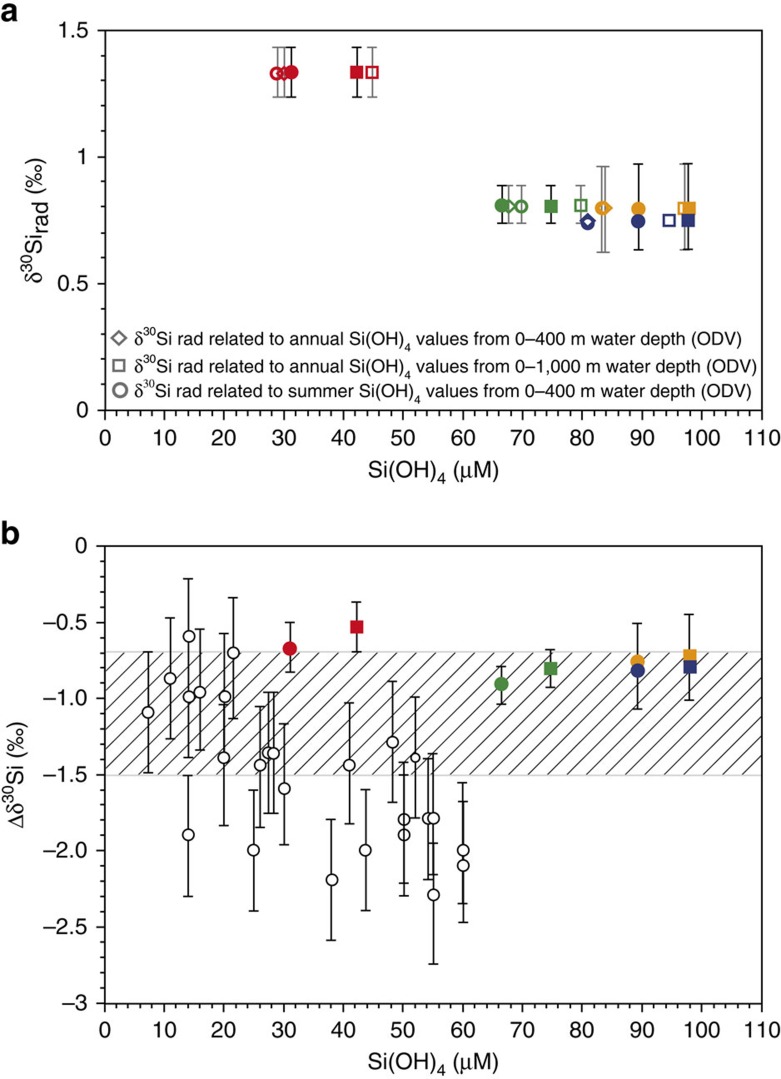
δ30Si data of radiolarians (δ30Sirad) and Δδ30Si offsets in surface sediments compared with Si(OH)4 concentrations and to Δδ30Si offsets of diatoms.(a) δ30Si data of radiolarians (δ30Sirad) in four surface sediments from the study area compared with Si(OH)4 concentrations in sea water. Colours refer to different surface sediments (red: PS63/026-2, green: PS63/035-2, blue: PS63/042-2, orange: PS63/043-2) (for site location, see Fig. 1 and Supplementary Table 3). Filled circles and squares present the δ30Sirad values (Supplementary Table 3) plotted versus Si(OH)4 concentrations measured at different water depth intervals (filled circles: upper ∼300–400 m and filled squares: upper 1,000 m) at nearby seawater sampling stations29 (Fig. 1 and Supplementary Table 3), whereas the open symbols display the δ30Sirad values plotted versus annual and summer Si(OH)4 concentrations at different water depth intervals in the study area according to the World Ocean Atlas33 (Supplementary Table 3). (b) Δδ30Si offsets between δ30Si values of seawater samples27282969 and δ30Si values of radiolarians (δ30Sirad) and diatoms (δ30Sidiat), respectively, versus seawater Si(OH)4 concentrations at the seawater sampling stations. Coloured symbols display different surface sediments (see Fig. 2a). Different symbols (circles and squares) display the Δδ30Si offsets between δ30Sirad values of the four surface sediment samples and seawater δ30Si values at different water depth intervals (filled circles: upper ∼300–400 m and filled squares: upper 1,000 m, see Fig. 2a) at the nearby oceanographic stations29 The dashed area illustrates the diatom δ30Si fractionation offset of −1.1±0.4‰ obtained from diatom culture studies24. The white dots with error bars display the Δδ30Si offsets between δ30Sidiat and δ30Si of seawater obtained from field data27282969. Error bars show ±2σ s.d.